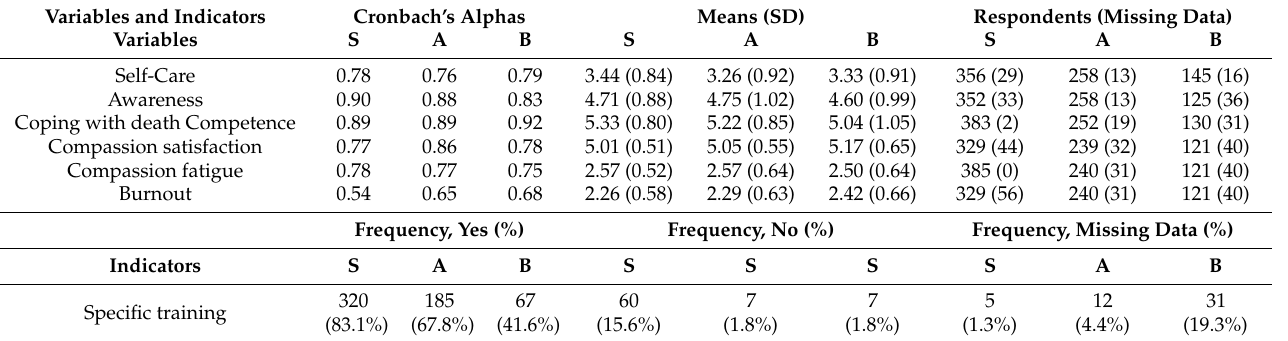
Table 2. Estimates of the internal consistency, descriptive statistics, and missing data for the variables under study. Variables and